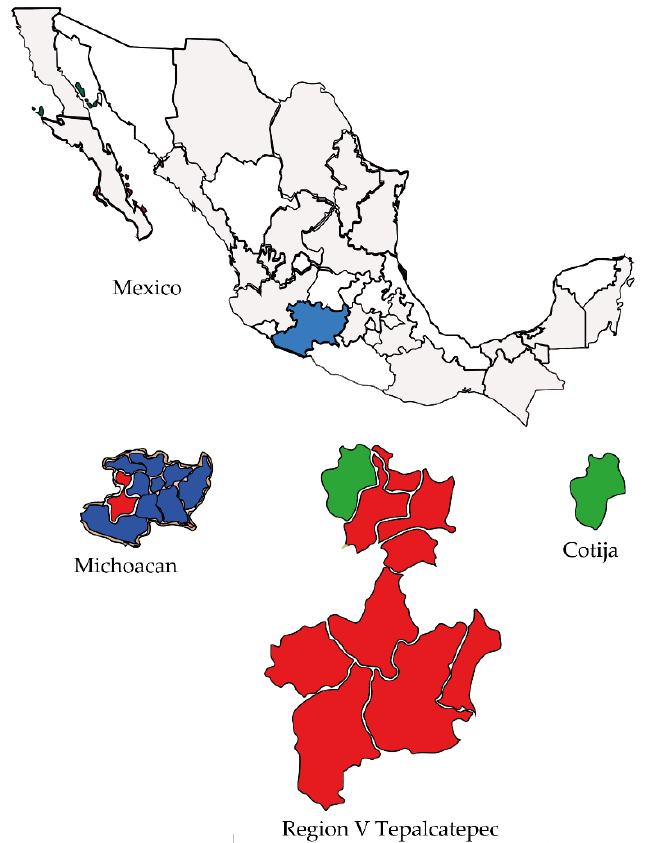
Figure 3. Cotija region in the State of Michoacan, Mexico.